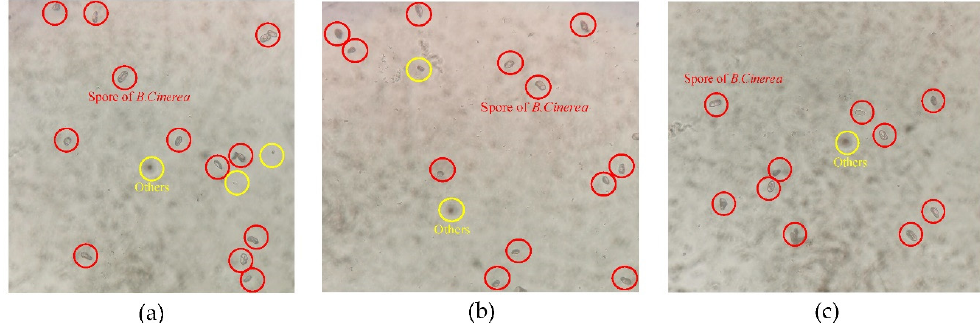
Figure 8. Experimental results of spores enrichment. ( a ) Example 1, ( b ) Example 2, ( c ) Example 3.